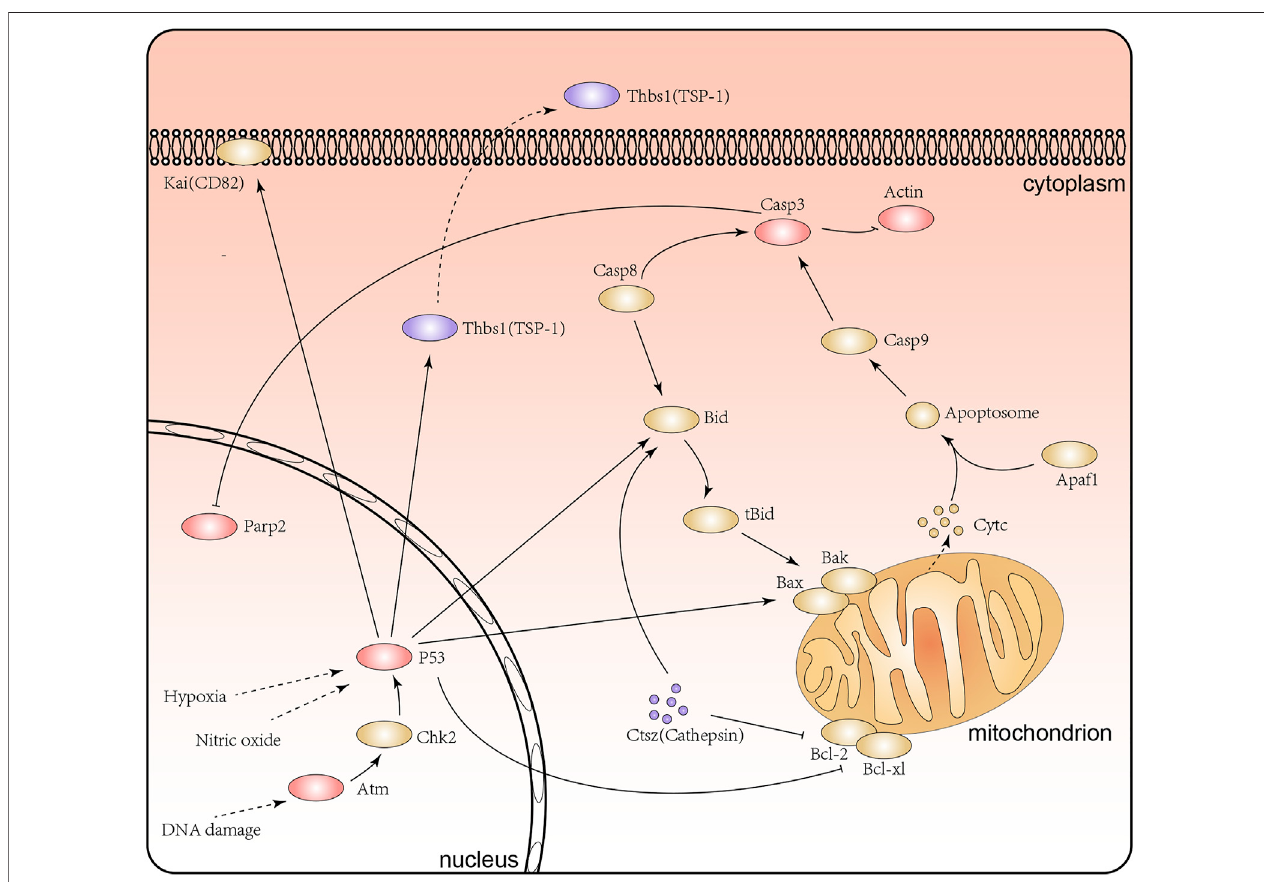
FIGURE 7 | The apoptosis signaling pathway and P53 signaling pathway in the renal tubular epithelial cells under high glucose conditions. Purple represents proteins with lower levels of acetylation, red represents proteins with higher levels of acetylation, and yellow represents proteins with no signi fi cant difference in acetylation